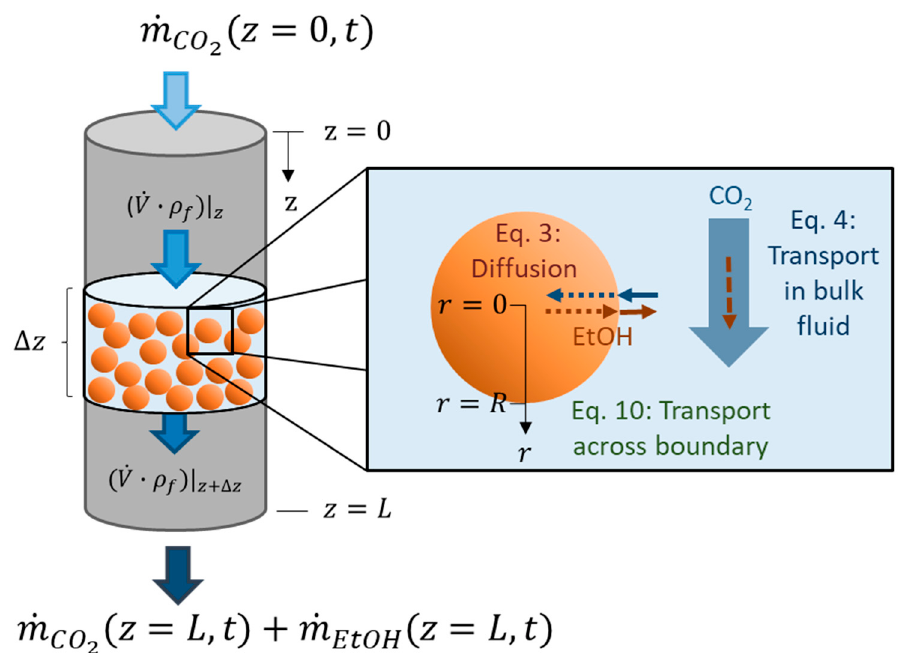
Figure 1. Supercritical drying of gel particles in a packed bed ( z —axial coordinate of packed bed, z = 0—top of packed bed, z = L —bottom of packed bed, ∆ z —slice of packed bed, 𝒎(cid:4662) 𝑪𝑶 . . m EtOH —ethanol flow, V —volume flow, ρ f —fluid density (mixture of CO 2 and ethanol), r —radial coordinate of spherical gel particle, r = 0—gel particle center, r = R —gel particle radius, t — time).